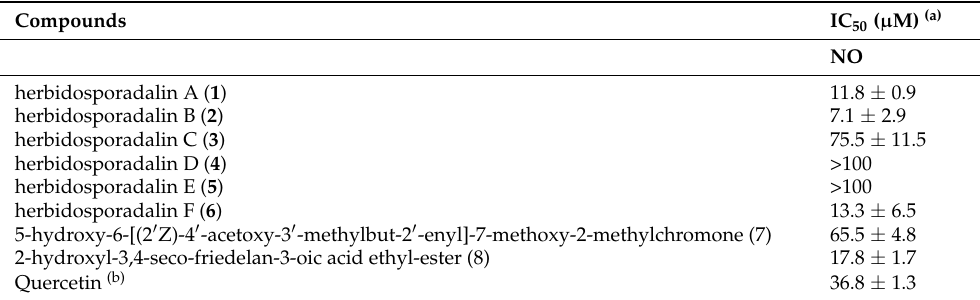
Table 3. Inhibitory effects of the isolates ( 1 – 8 ) on NO generation by RAW 264.7 murine macrophages in response to lipopolysaccharide